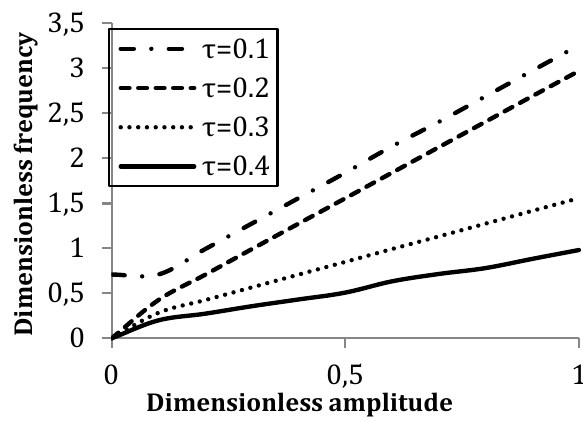
Figure 4: Dimensionless frequency vs. dimensionless amplitude for various non-local parameter. ( L / h = 10 , V = 0 , K w = K p = 20 , ∆T = 20 ∘ , α = 0.5 )